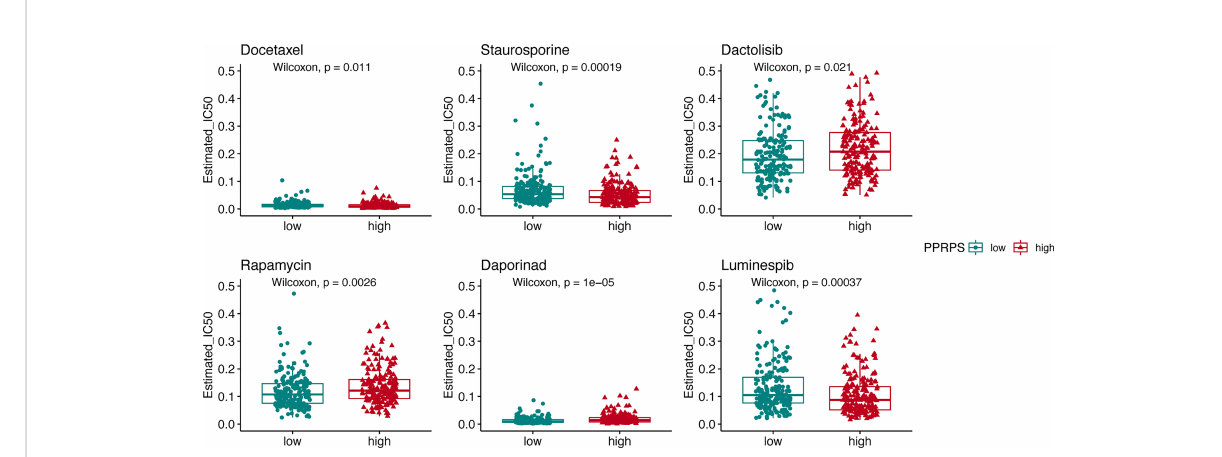
FIGURE 9 The pan-PCD score of chemotherapeutic agents during the courses of cancer chemotherapy. The IC 50 values of chemotherapeutic agents among the high- and low-PPRPS groups are shown in the fi